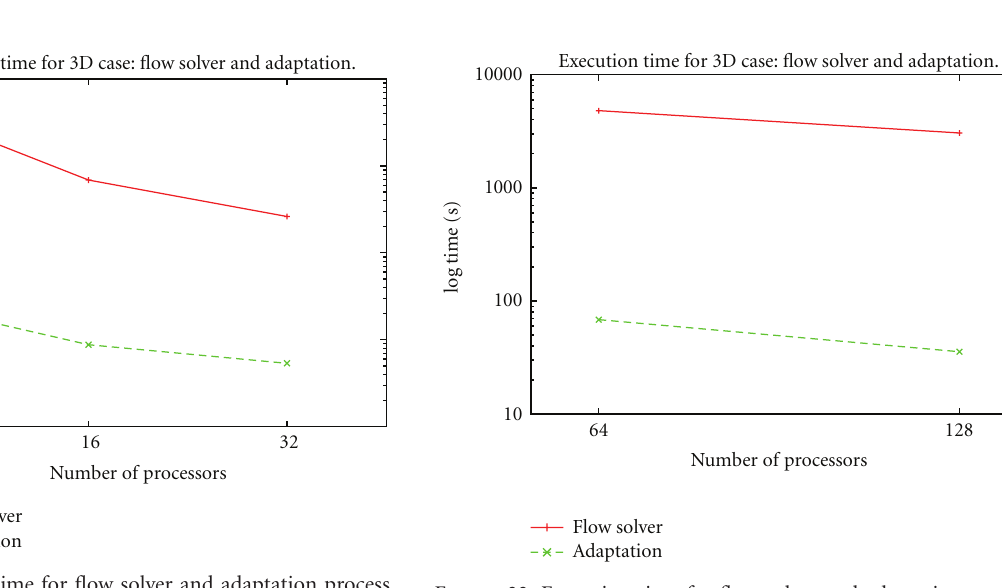
Figure 22: Execution time for flow solver and adaptation process on multiple processors. 3D wedge, one adaptation step after